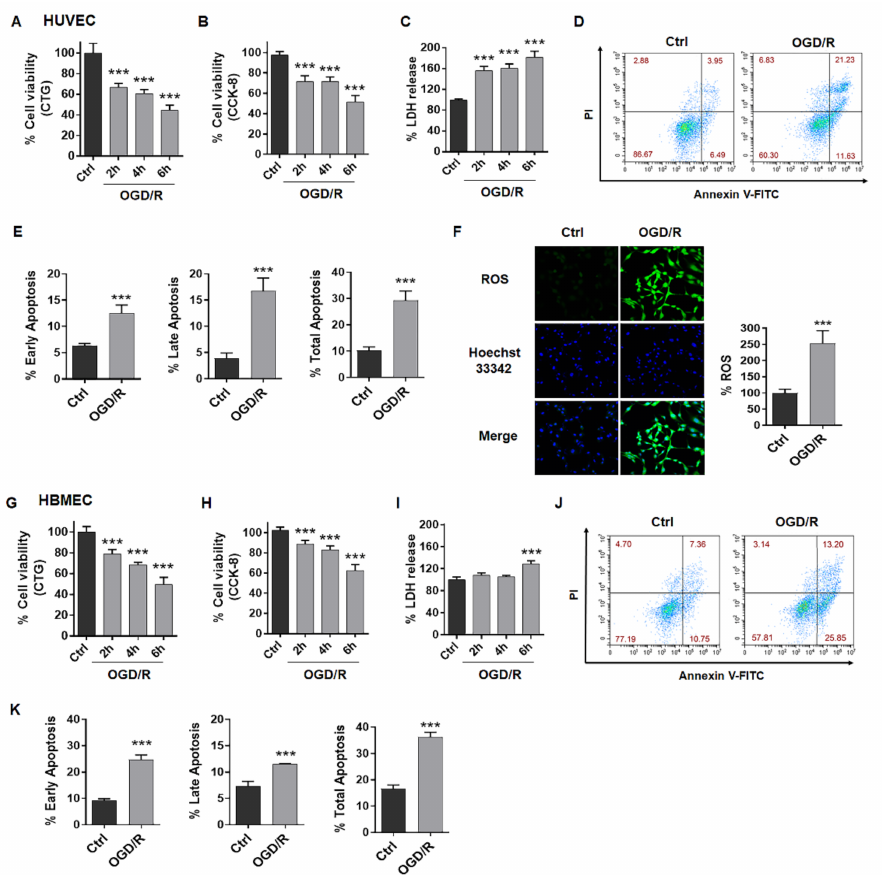
Figure 1. OGD/R induces injury in ECs. ( A ) Cell viability of HUVECs was tested after OGD for 2 h, 4 h or 6 h and reperfusion for 24 h using CTG assay. ( B ) Cell viability of HUVECs was tested after OGD for 2 h, 4 h or 6 h and reperfusion for 24 h using CCK-8 assay. ( C ) LDH release of HUVECs was tested after OGD for 2 h, 4 h or 6 h and reperfusion for 24 h. ( D , E ) FCM analysis showed apoptosis in HUVECs after OGD4h/R24h. ( F ) Images and graph showed ROS produced in OGD4h/R24h-treated HUVECs. ( G ) Cell viability of HBMECs was tested after OGD for 2 h, 4 h or 6 h and reperfusion for 24 h using CTG assay. ( H ) Cell viability of HBMECs was tested after OGD for 2 h, 4 h or 6 h and reperfusion for 24 h using CCK-8 assay. ( I ) LDH release of HBMECs was tested after OGD for 2 h, 4 h or 6 h and reperfusion for 24 h. ( J , K ) FCM analysis showed apoptosis in HBMECs after OGD6h/R24h. OGD/R, oxygen and glucose deprived/reperfusion. LDH, lactate dehydrogenase. HUVECs, human umbilical vein endothelial cells. HBMECs, human brain microvascular endothelial cells. The data are presented as the means ± SD, and were assessed using t test or one-way ANOVA. *** p < 0.001 vs. the Ctrl group. n = 3–4 for